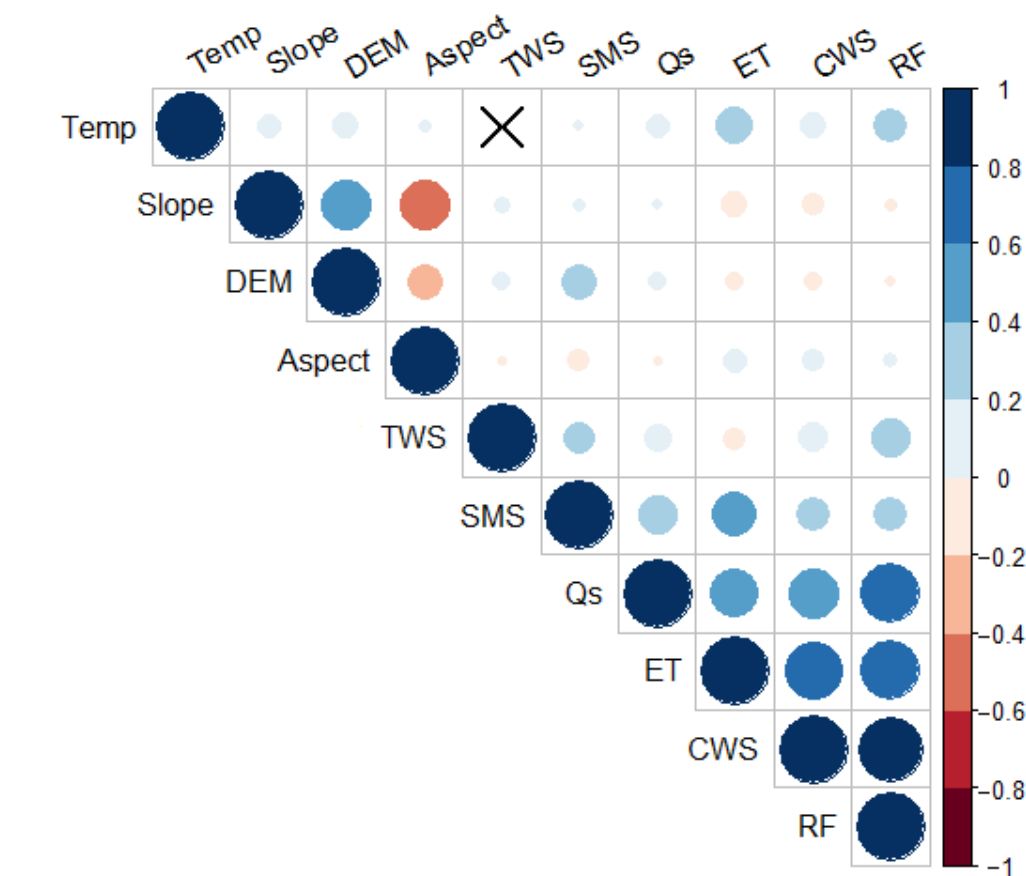
Figure 4. Correlation plot of model input variables. The cell with an “X” indicates a statistically insignificant correlation ( p < 0.05).